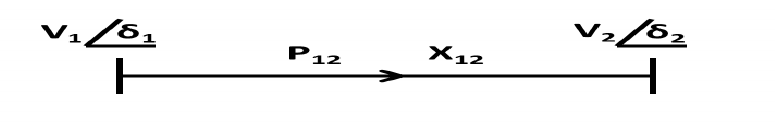
Figure 1. Transmission line model in